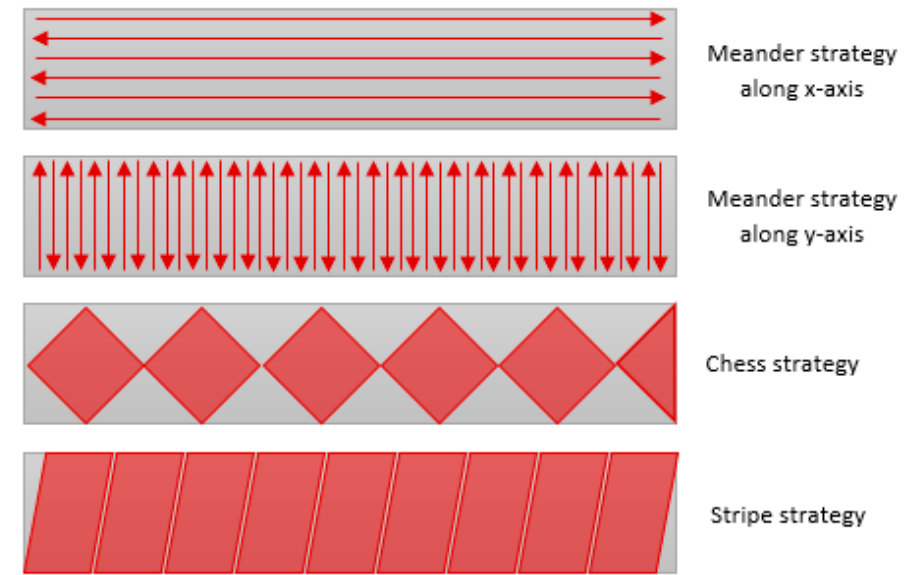
Figure 5. Examples of different scanning strategies on a rectangular cross section—the direction of scan lines inside the red areas can vary from layer to layer, selecting a non-zero rotation angle (according to Figure 3) between subsequent layers.